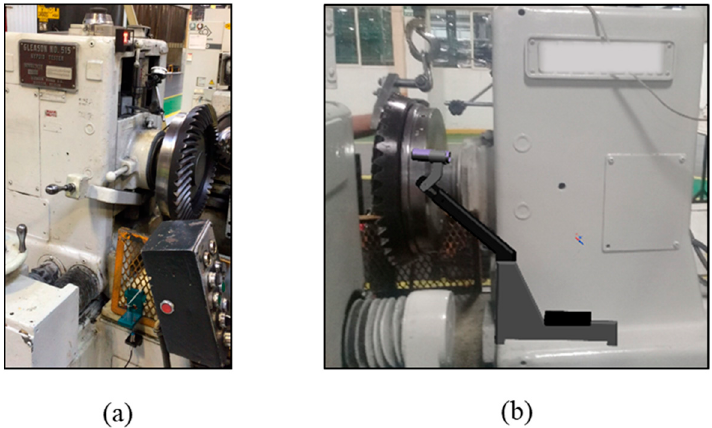
Figure 3. Gear testing machine. ( a ) Gear mount areas seen for the position of the operator. ( b ) Proposed location for test system with Conceptual CAD model of support.